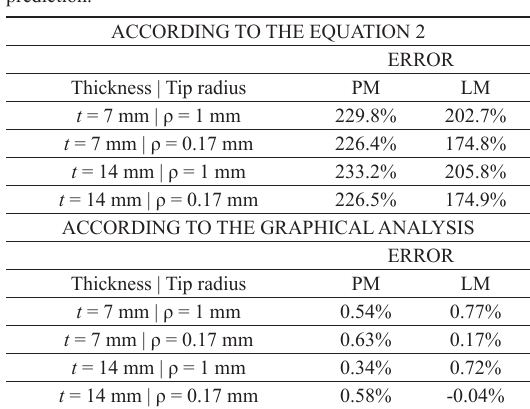
Table 8. Percentage error for U-notched stress intensity factor